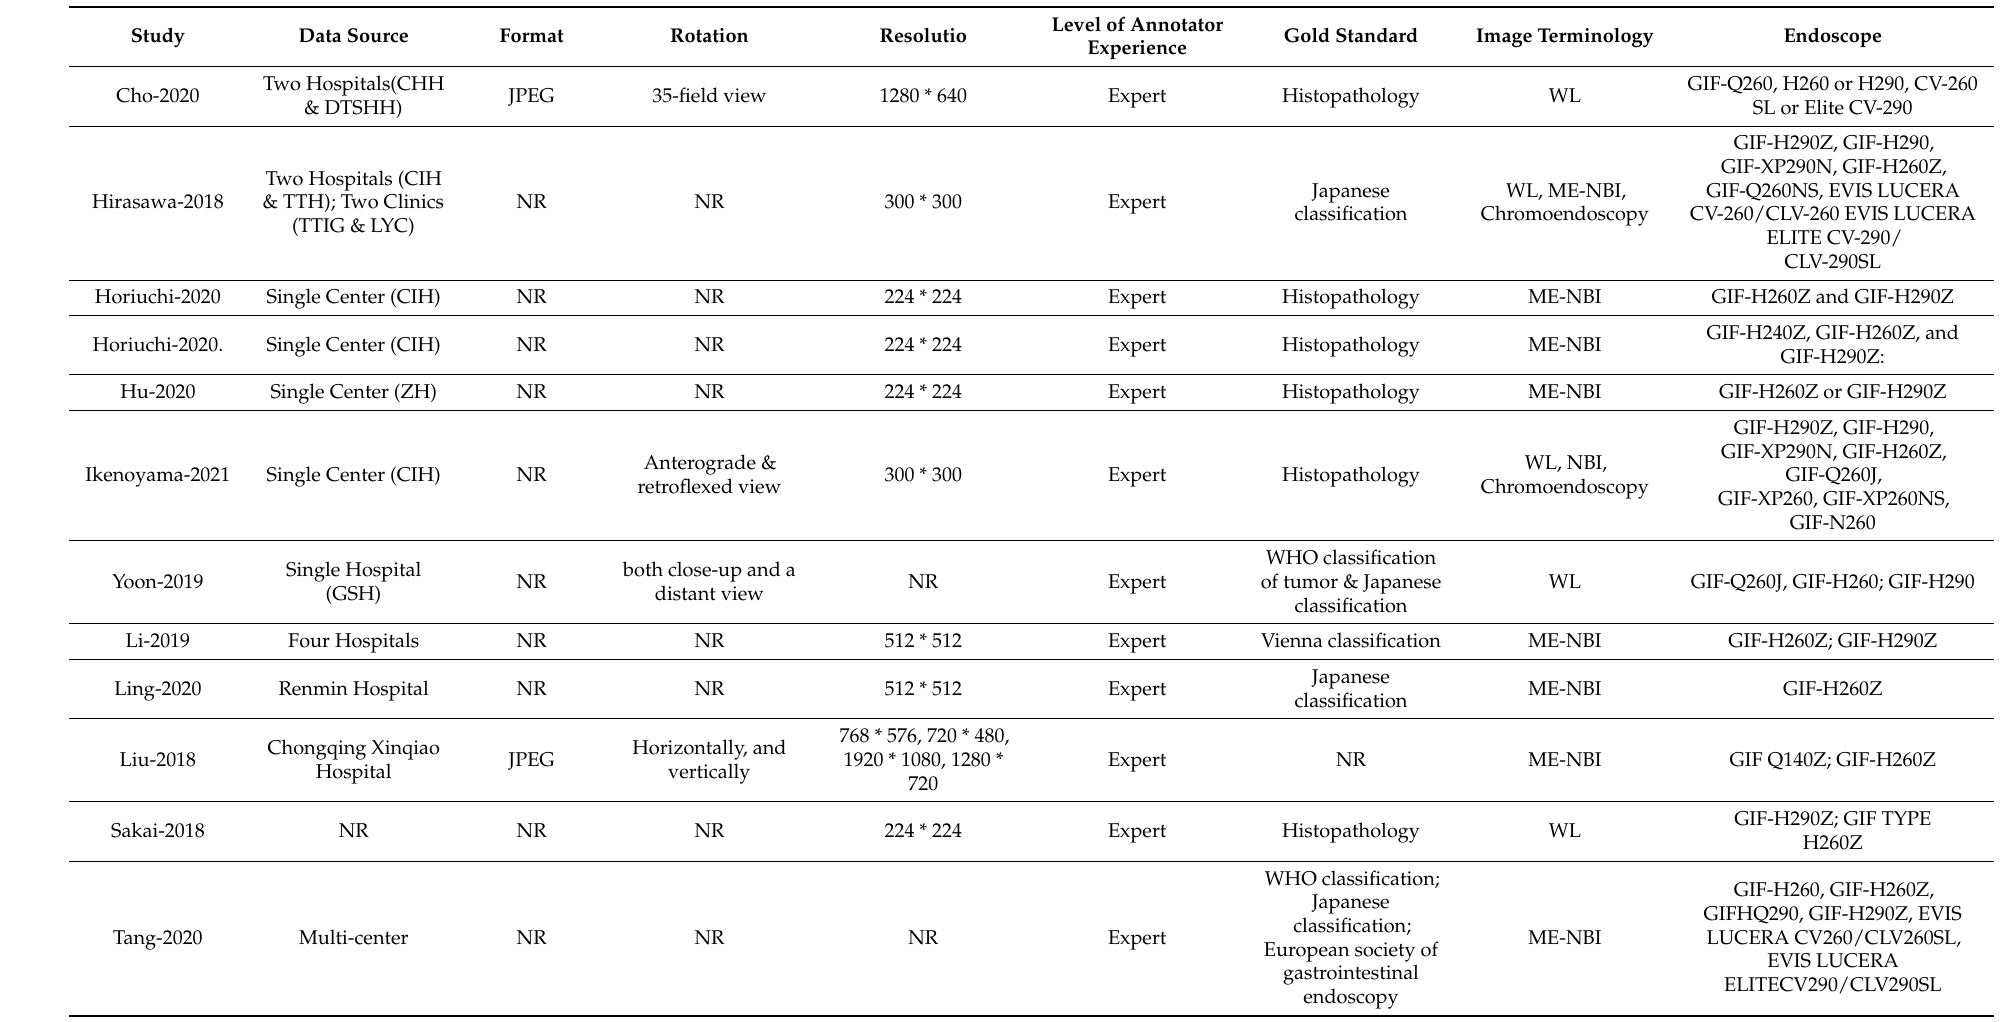
Table 2. Description of endoscopy and